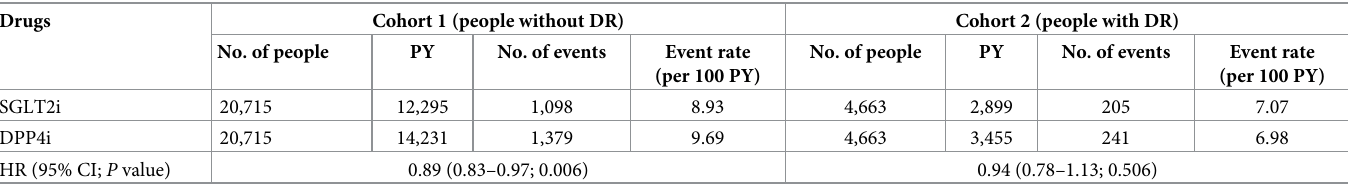
Table 2. HRs for the occurrence and progression of DR in propensity score-matched